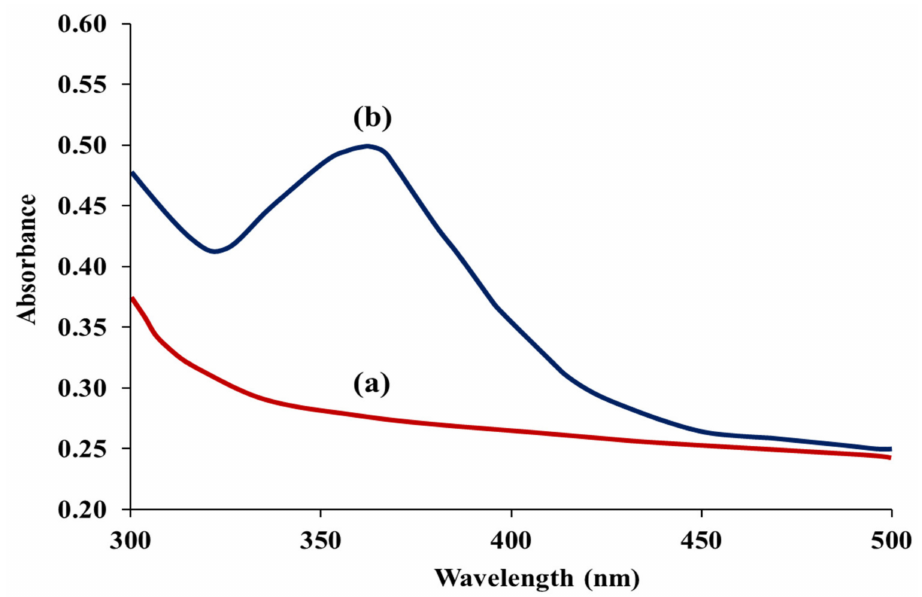
Figure 2. Absorption spectra of the proposed method ( a ) in the absence and ( b ) in the presence of 0.600 mg L − 1